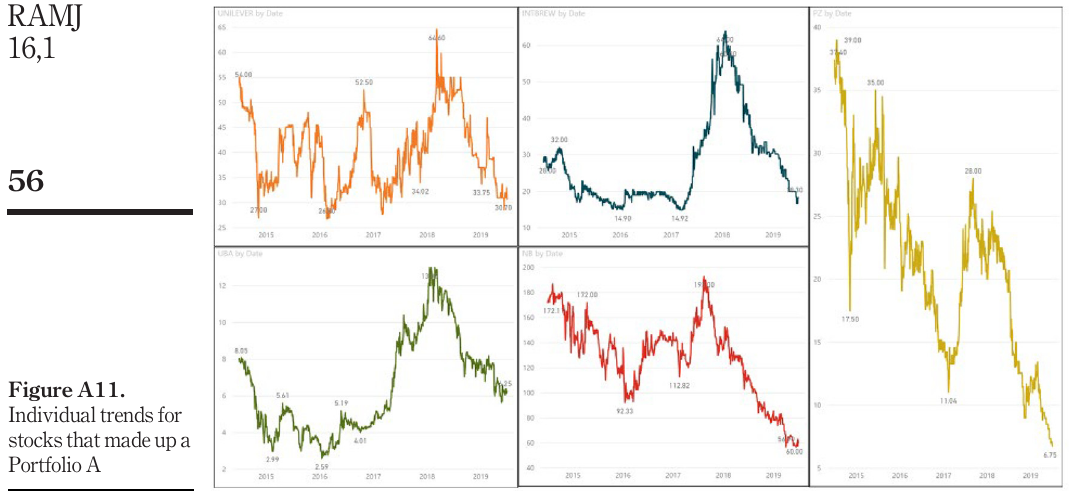
Figure A11. Individual trends for stocks that made up a Portfolio